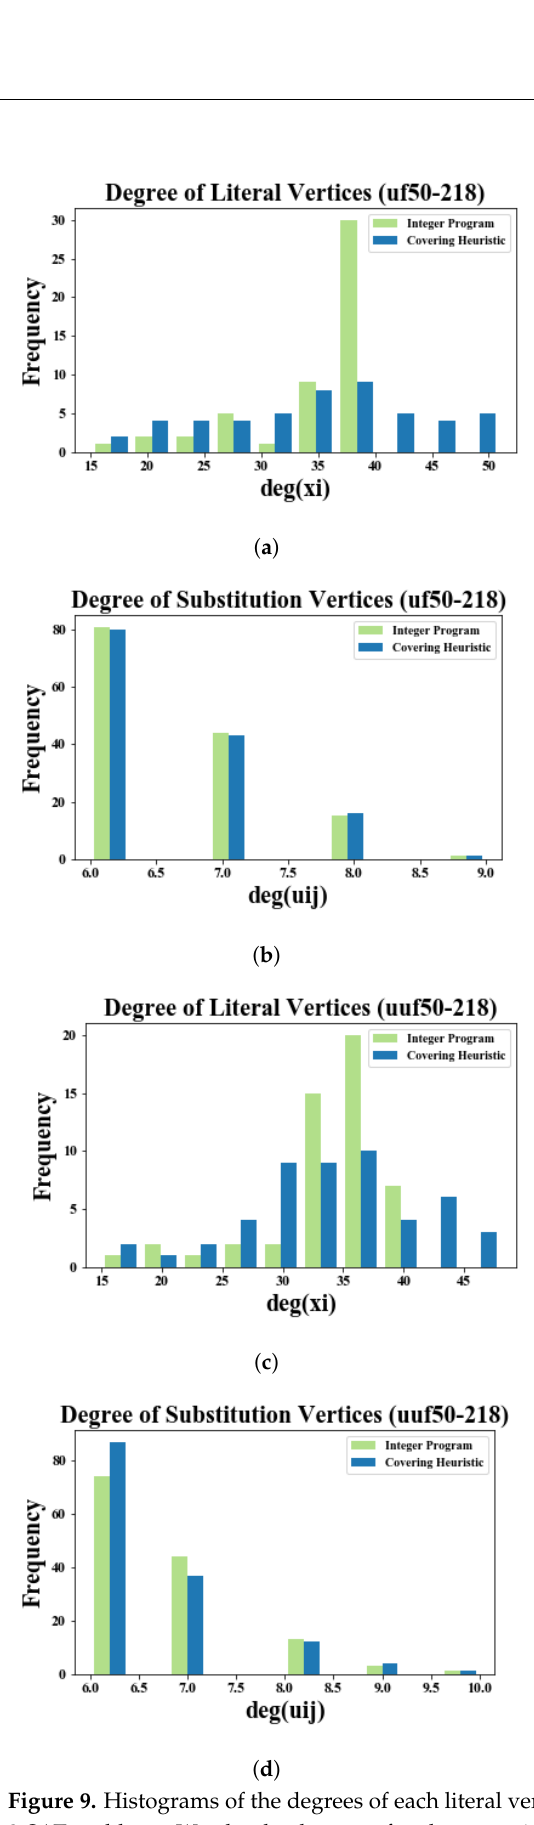
Figure 9. Histograms of the degrees of each literal vertex or substitution vertex for specific uniform 3-SAT problems. We plot the degrees of each vertex since the unitary circuit depth for one iteration is either the maximum degree plus one or the maximum degree plus